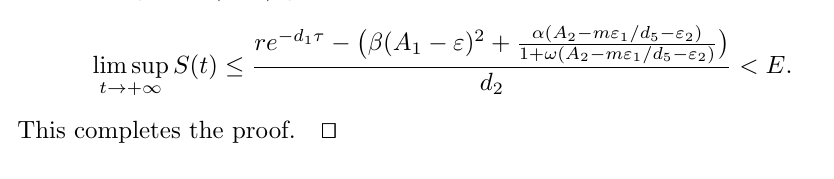
which along with (2.30)